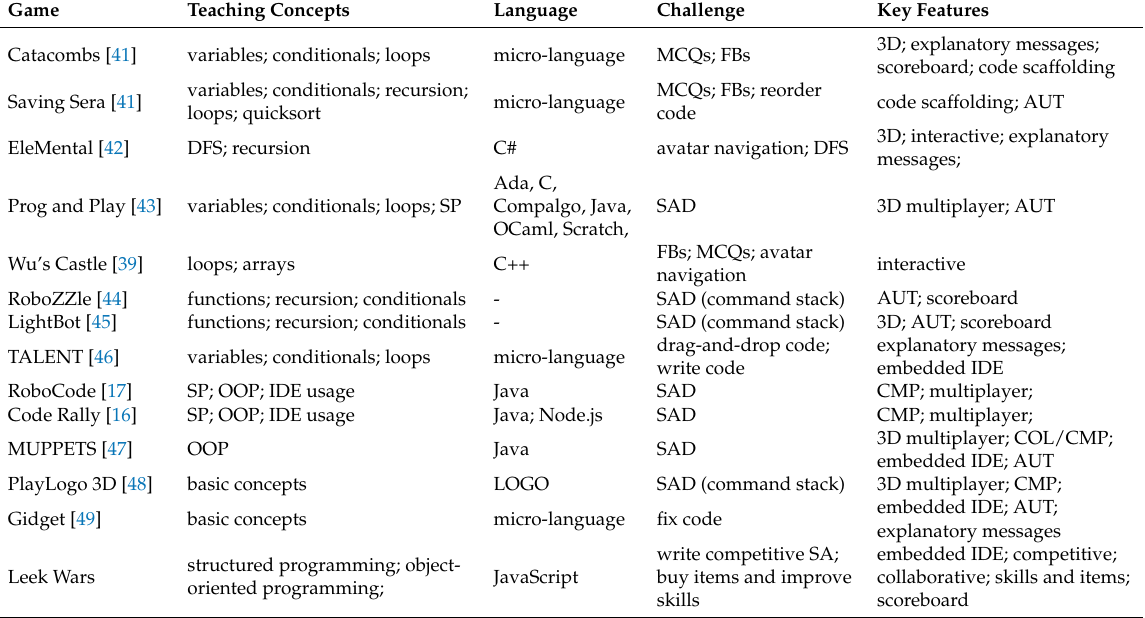
Table 1. Overview of serious games to teach